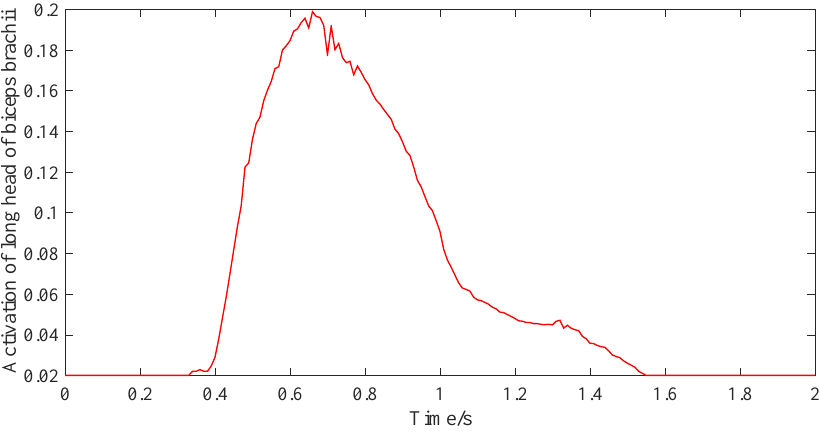
Figure 14. Activation of the long head of the biceps brachii during flexion.